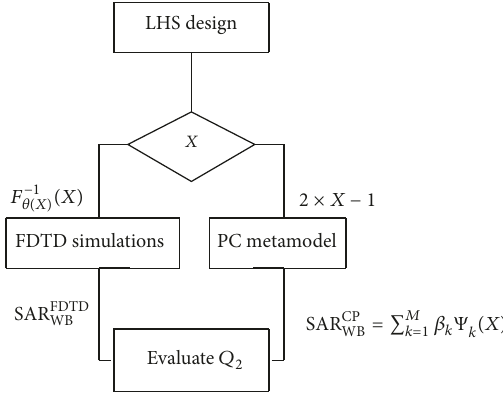
Figure 16: Flowchart of the proposed approach.